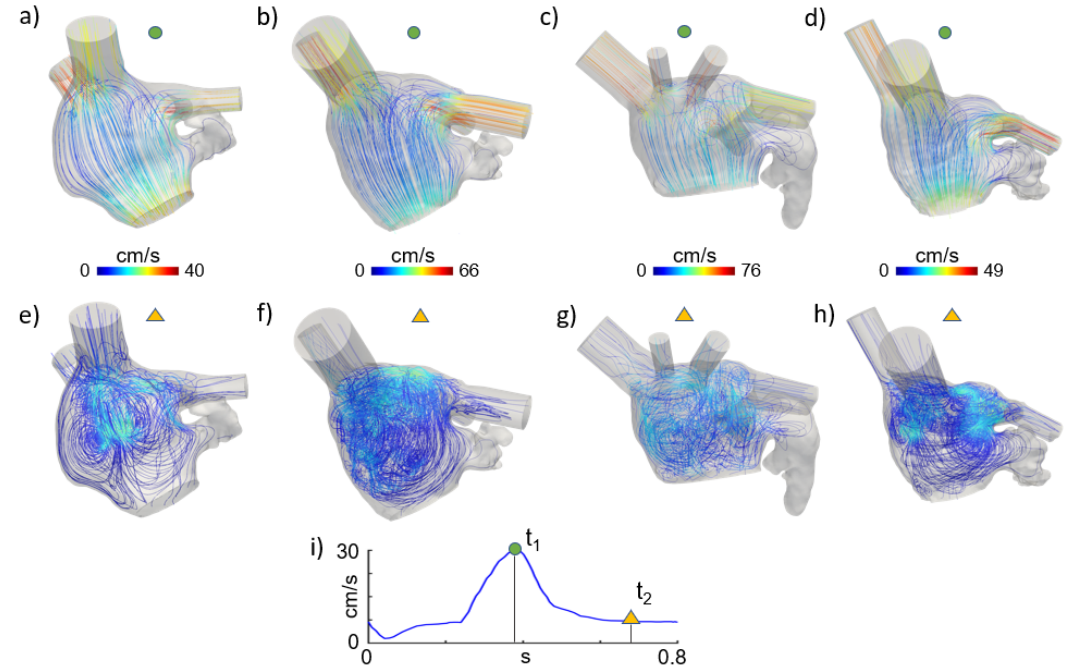
Figure 6. Velocity streamlines of each LAA morphology, i.e., CW ( a , e ), CF ( b , f ), WS ( c , g ) and CS ( d , h ) with the respective LA at t 1 time ( a–d ) and at t 2 time ( e – h ) of the cardiac cycle in terms of MV velocity profile ( i